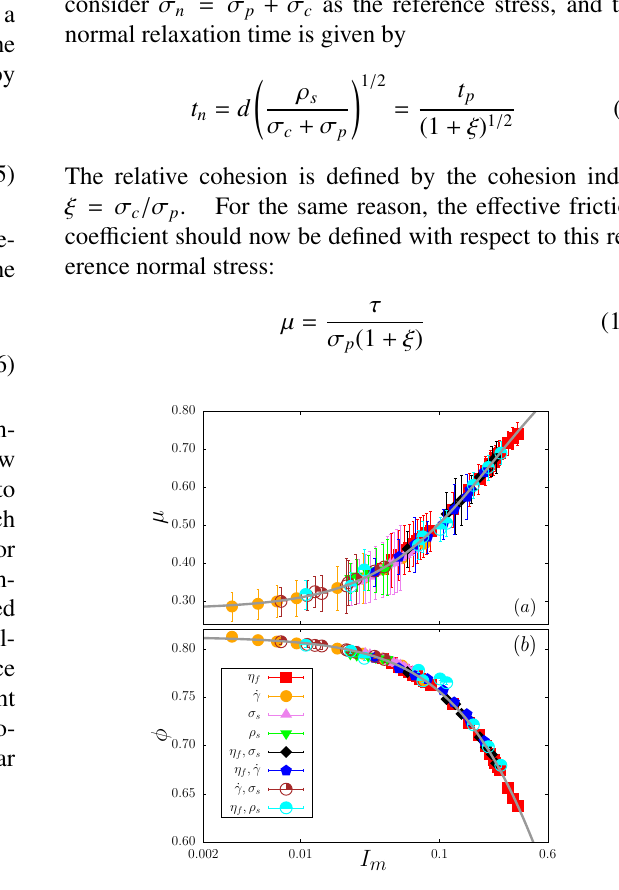
Figure 3. E ↵ ective friction µ and packing fraction  as a func- tion of the control parameter I m (see text) in a 2D sheared dense suspension simulated by coupled DEM-LBM for a broad range of parameters. In each series of simulations the values of all pa- rameters are kept constant except those with the color and symbol indicated